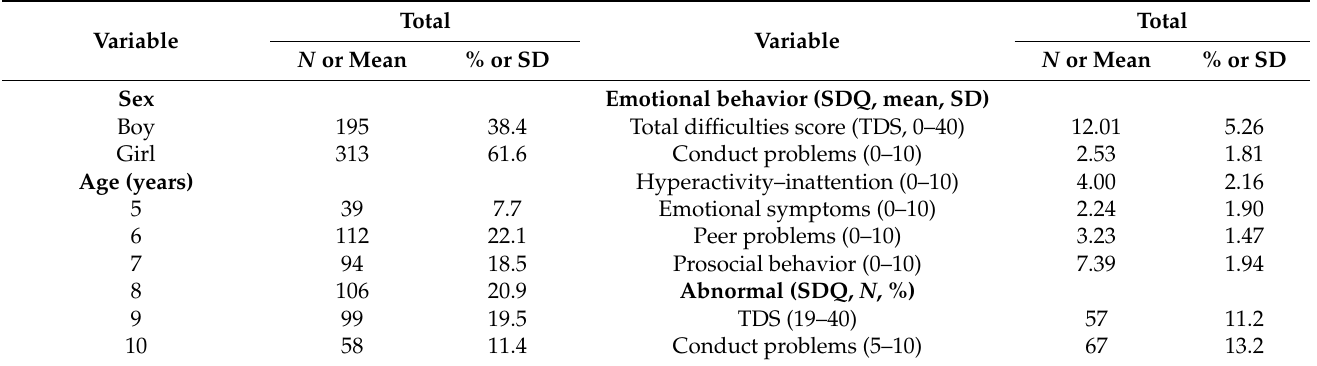
Table 1. Characteristics of schoolchildren (5–10 years old) in Sri Lanka ( n =